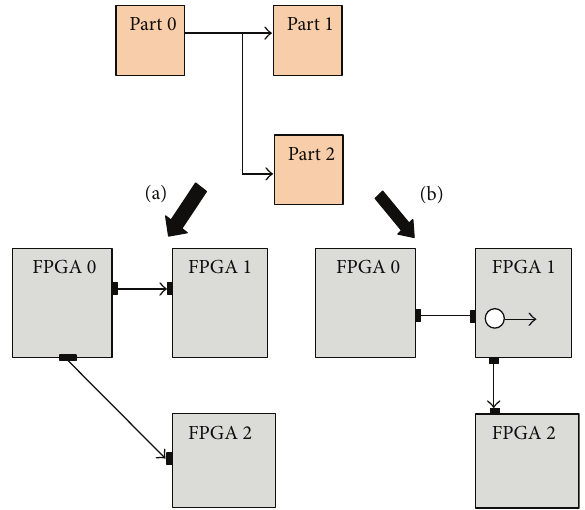
Figure 10: Routing solutions of multiterminal